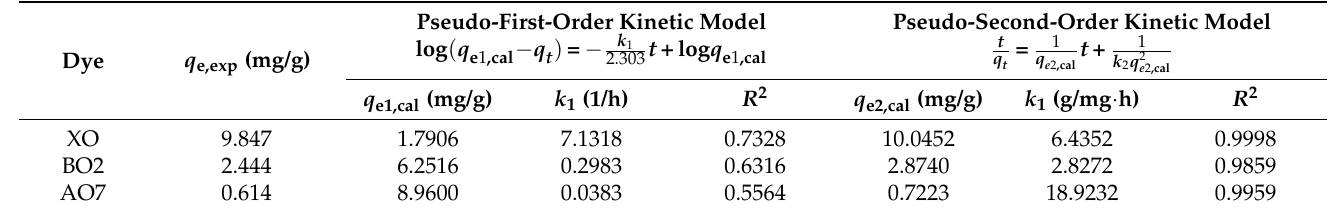
Table 4. Kinetic parameters for the adsorption of XO, BO2, and AO7 dyes onto Fe 3 O 4 nanoparticles at room